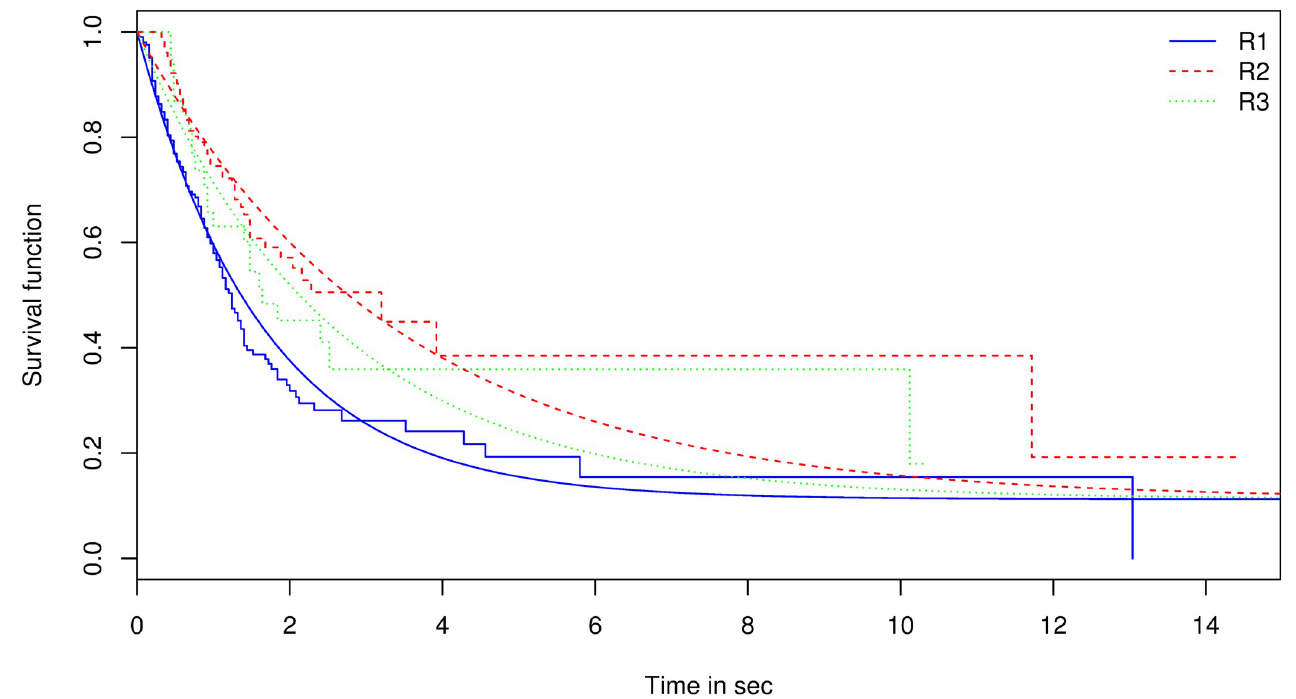
Fig 5. Kaplan Meir and adjusted survival functions for the first escapement attempt (solid blue line); second escapement attempt (dashed red line) and the first and subsequent escapement attempts (green dotted line).